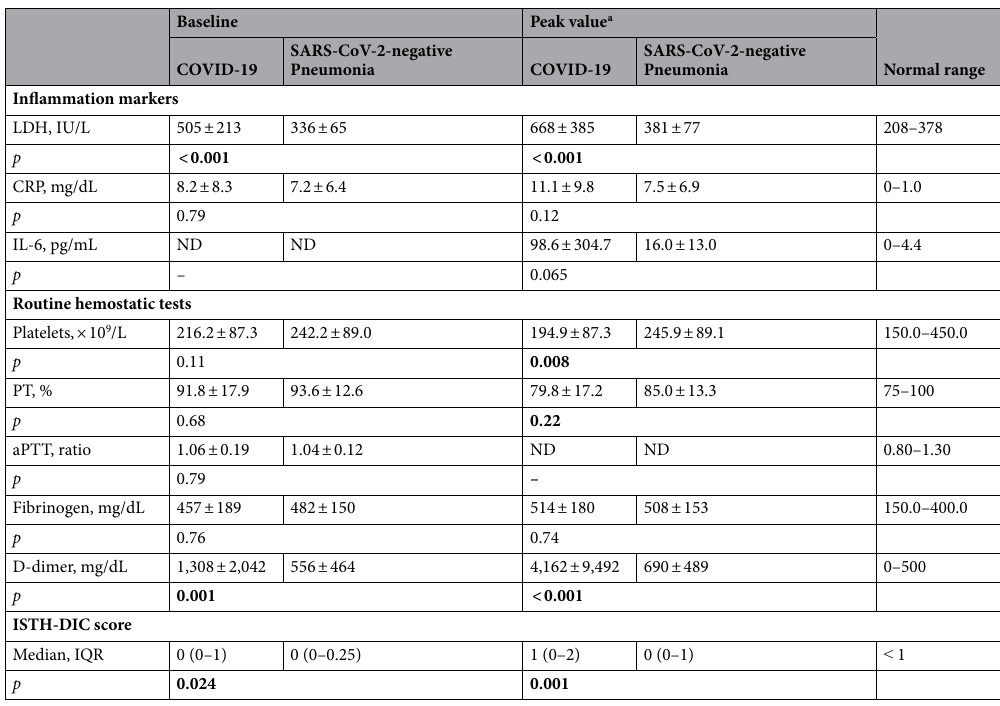
Table 3. Baseline and peak laboratory parameters in COVID-19 patients and in those with SARS-CoV-2 negative pneumonia. Data are shown as mean ± SD. Bold values denote statistical significance at the p < 0.05 level. aPTT activated partial thromboplastin time, CRP C-reactive protein, IL-6 interleukin-6, LDH lactate dehydrogenase, PT prothrombin time, O.D. optical density. a Peak or minimum values of each laboratory parameter are shown, depending on its upward or downward tendency during COVID-19, respectively. P values were based on Mann–Whitney-U test or T-test.